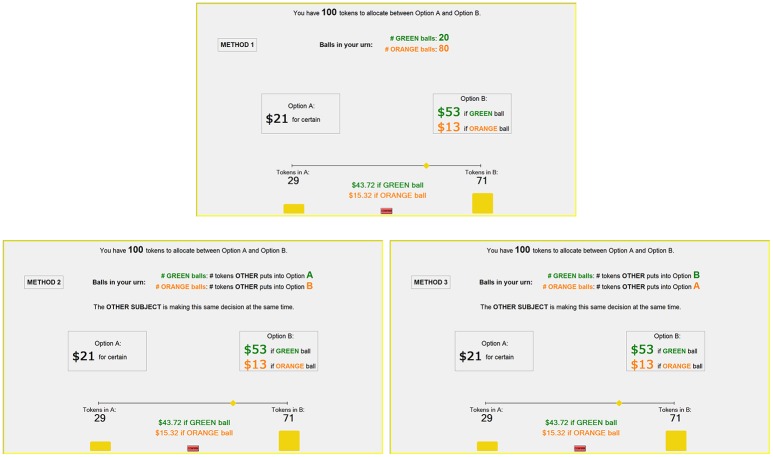
Screenshot of LO (Method 1), HD (Method 2), and SH (Method 3).